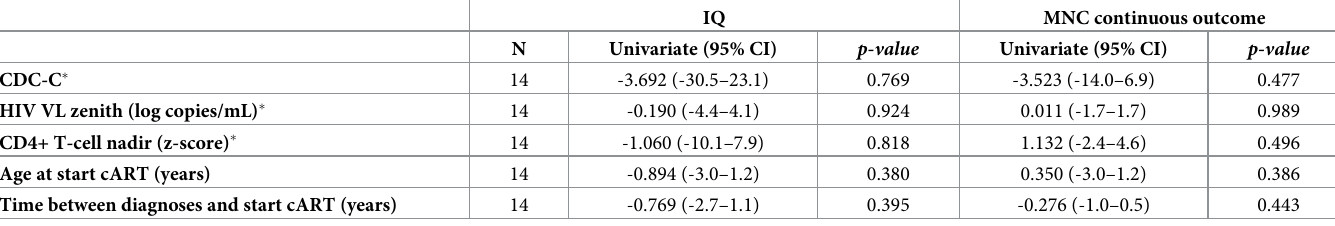
Table 3. Associations between HIV- and cART-related variables and intellectual performance in PHIV